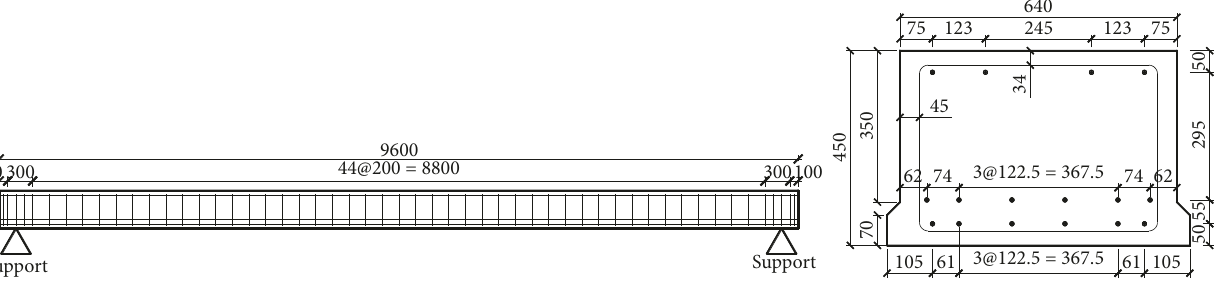
Figure 1: Diagram of PC girders (unit: mm).